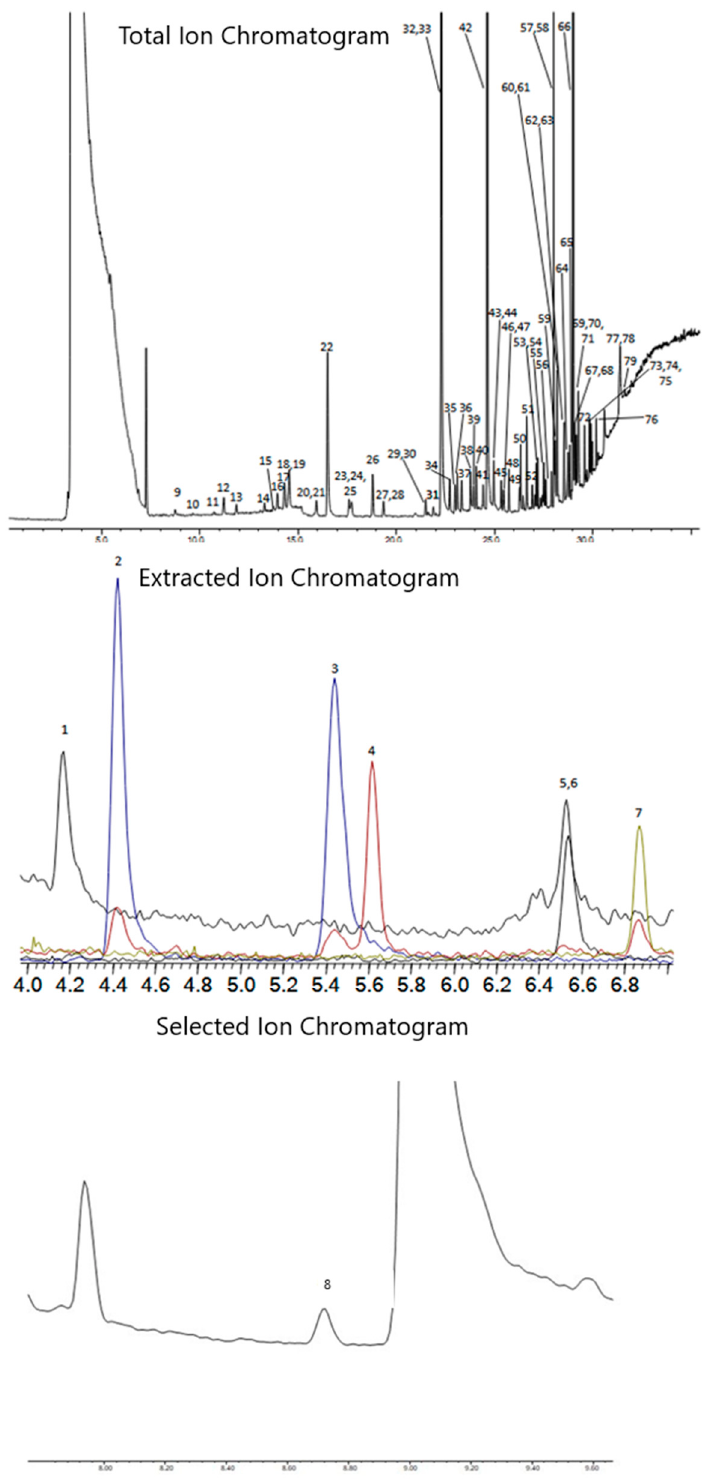
Figure 3. Combined TO-15A and EtO chromatograms. TO-15A compounds at 200 ppt v, EtO at 50 ppt v , and internal standards at 5000 ppt v. Top chromatogram is the Total Ion Chromatogram (TIC), second trace is the Extracted Ion Chromatograms (EIC) for compounds 1–7 ( m / z 41, 85, 135, 50, 43, 65, and 54), and the bottom trace is the Selected Ion Monitoring (SIM) trace for EtO ( m / z